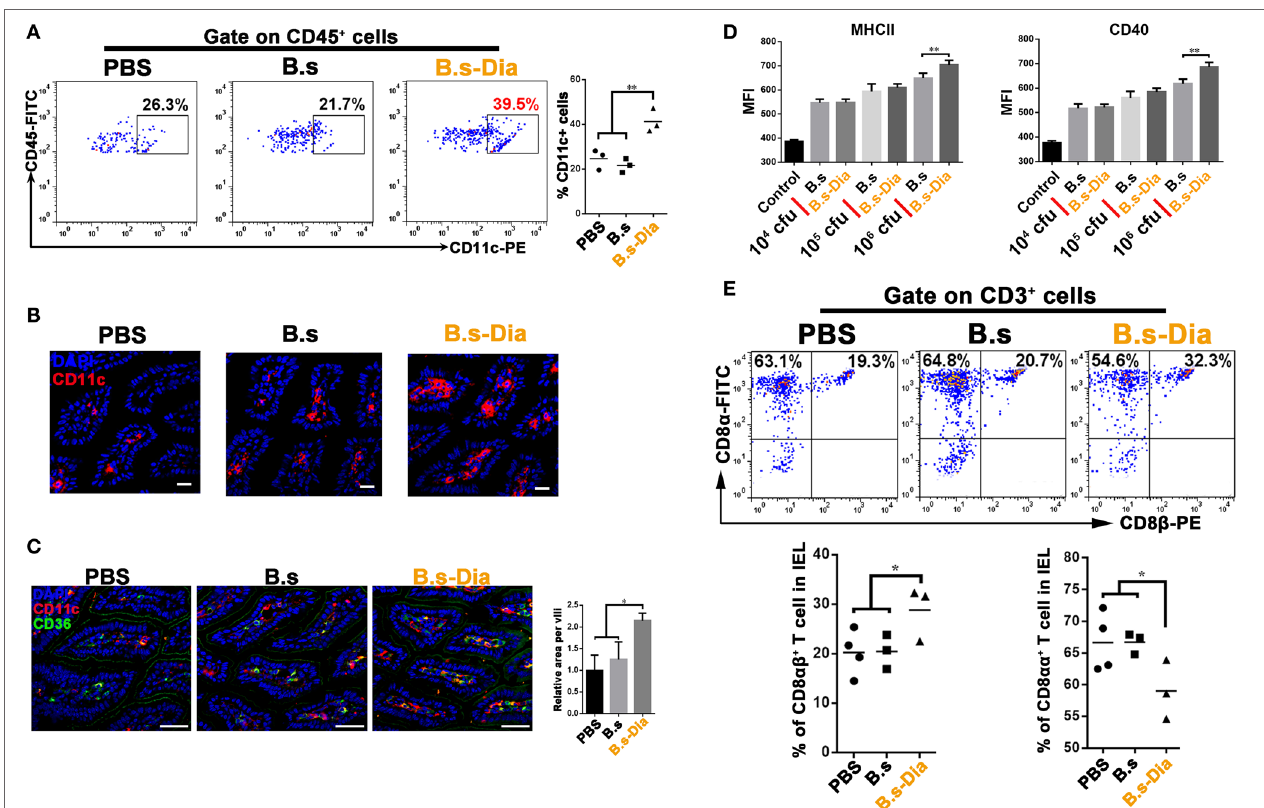
FigUre 3 | intragastric administration of 4,4 ′ -diaponeurosporene-producing Bacillus subtilis (B.s-Dia) increased the number of lamina propria (lP) dendritic cells and reduced the proportion of cD8 αα + intraepithelial lymphocytes (iels) . Mice were intragastrically administrated of PBS, 1 × 10 9 colony forming units B.s or B.s-Dia for 7 days. (a) The frequencies of CD45 + CD11c + cells in small intestinal LP cells of the indicated mice were analyzed by flow cytometry. (B) Immunostaining of small intestines from the corresponding mice in (a) was shown. (c) The expression of CD36 (green) on CD11c + cells (red) of the indicated mice was detected by confocal microscope. (D) The expression of MHCII and CD40 of CD11c + cells with the indicated treatments was detected by flow cytometry. (e) The frequencies of IELs of the indicated mice were analyzed by flow cytometry. One representative of three similar independent experiments is shown. Asterisks indicate statistical significance via the one-way ANOVA test (* P < 0.05, ** P < 0.01). Scale bar, 100